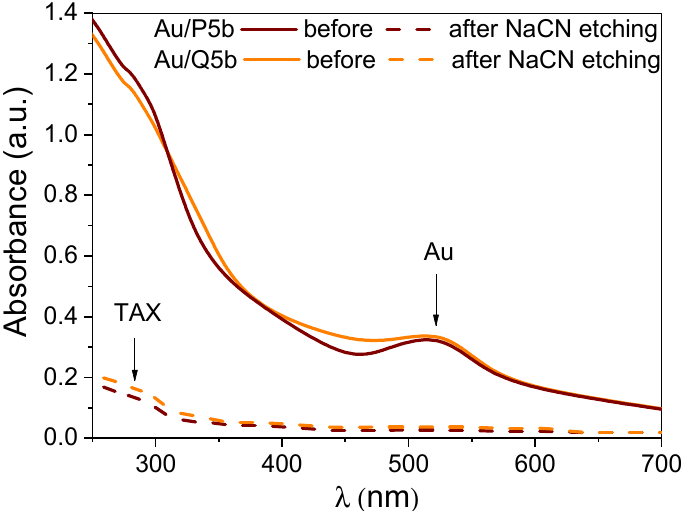
Figure 6. UV-vis spectra of gold@pentablock terpolymer nanoparticles loading TAX, at 0.2 mg/mL in PBS at pH 7.4, before and after NaCN etching.